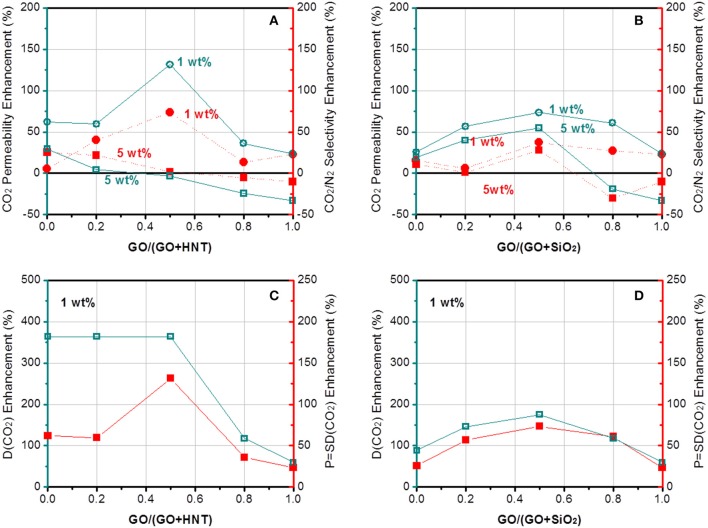
The enhancement of (A,B) CO2 permeability and CO2/N2 selectivity and (C,D) CO2 diffusivity of Pebax-GO/HNT and Pebax-GO/SiO2 membranes.